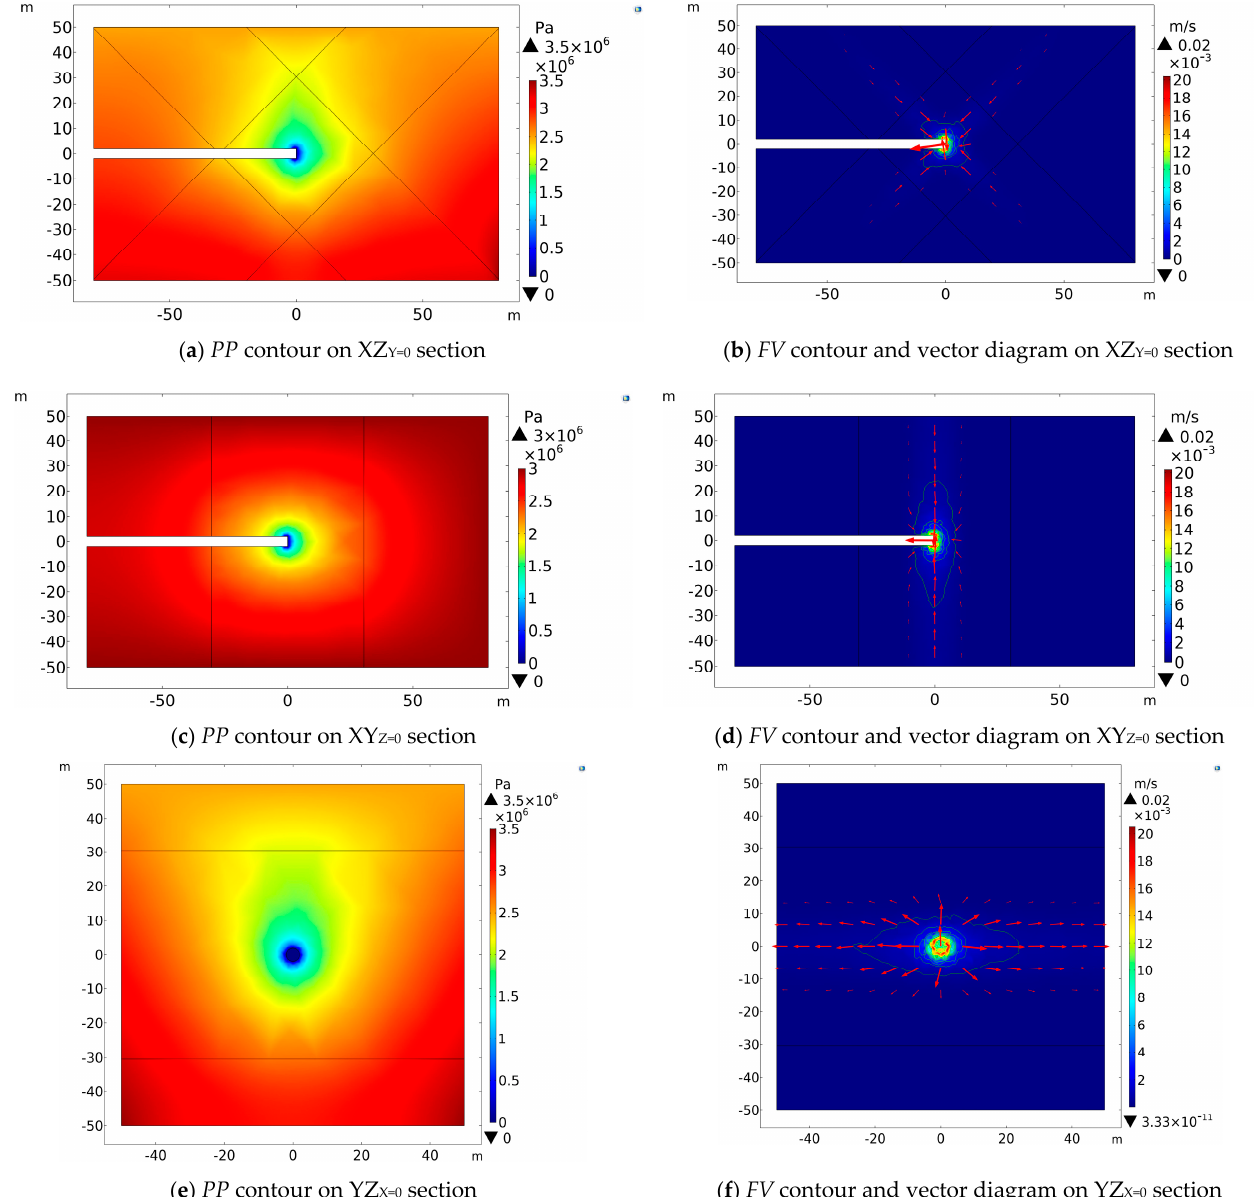
( f ) FV contour and vector diagram on YZ X=0 section Figure 6. Simulation results for the case Y = 0